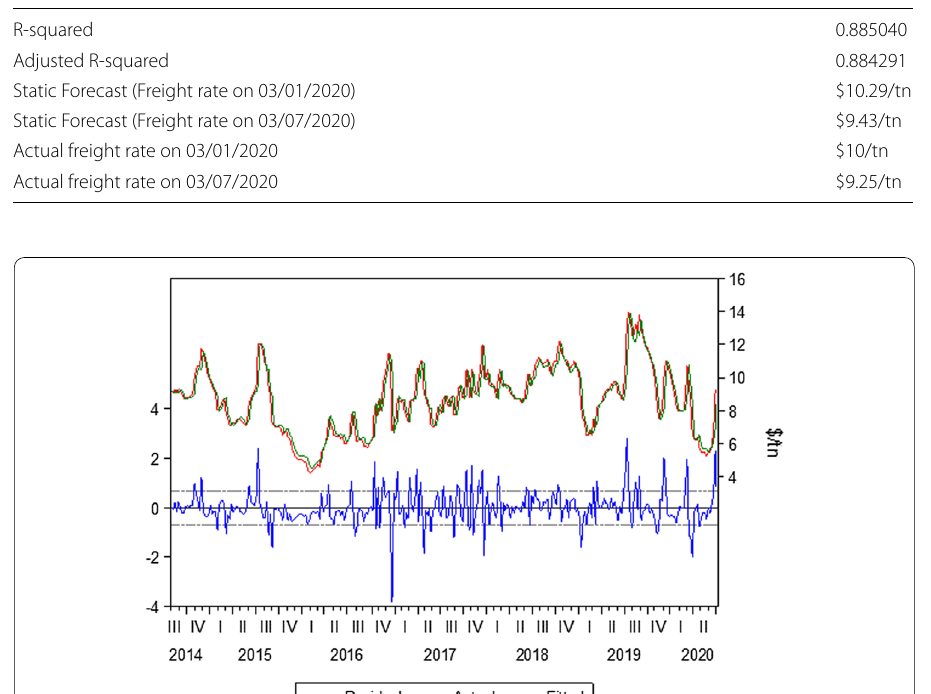
Fig. 2 Kamsar–San ciprian bauxite. Source : Elaboration by the